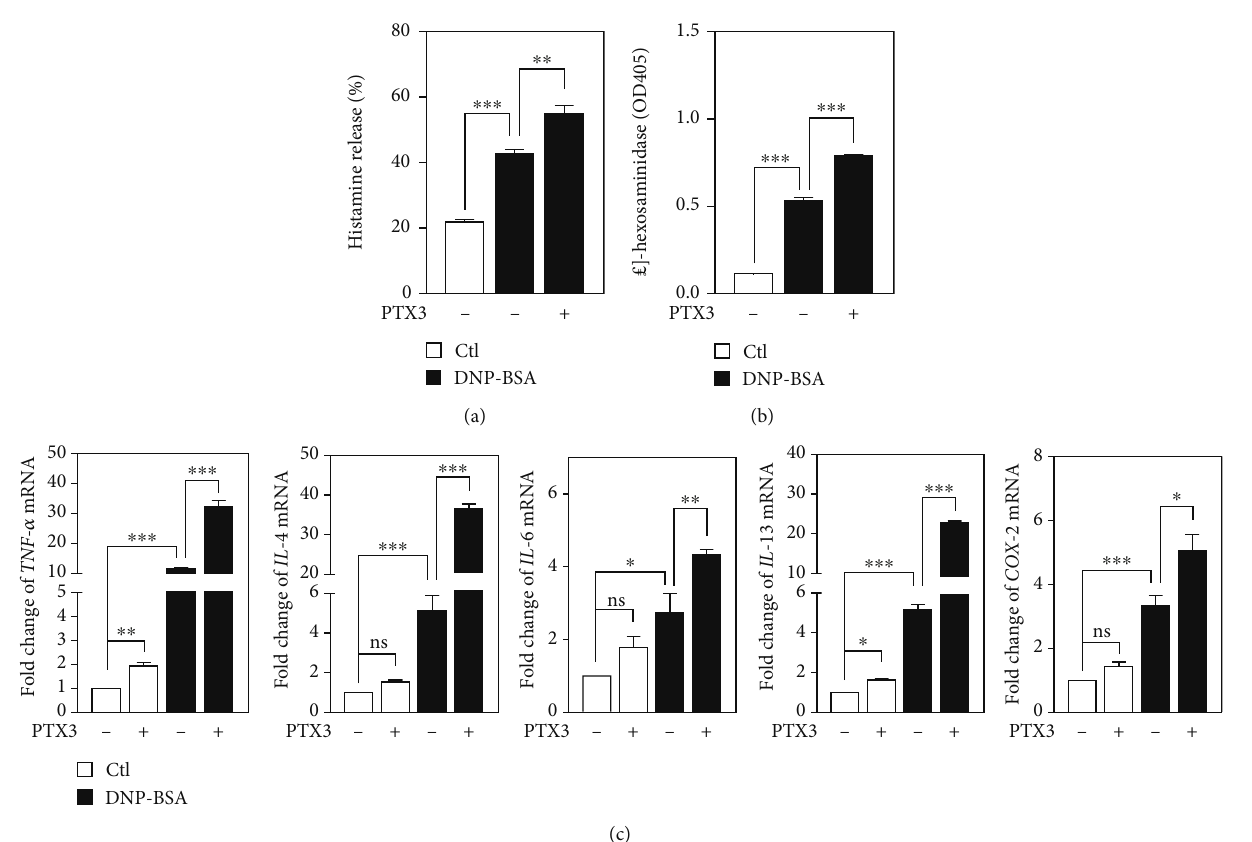
Figure 2: PTX3 augments degranulation and production of proin fl ammatory mediators in IgE/Ag-activated RBL-2H3 cells. (a, b) RBL-2H3 cells were seeded on a 24-well plate and further incubated with DNP-IgE overnight. IgE-sensitized cells were preincubated with PTX3 (300ng/ml) for 30min and then stimulated with DNP-BSA for 15min. Histamine content and β -hexosaminidase activity were determined as described in the Materials and Methods. (c) E ff ects of PTX3 on the mRNA levels of TNF- α , IL-4 , IL-6 , IL-13, and COX-2 in IgE/Ag-stimulated RBL-2H3 cells were determined by qPCR. mRNA level of β -actin was used as an internal